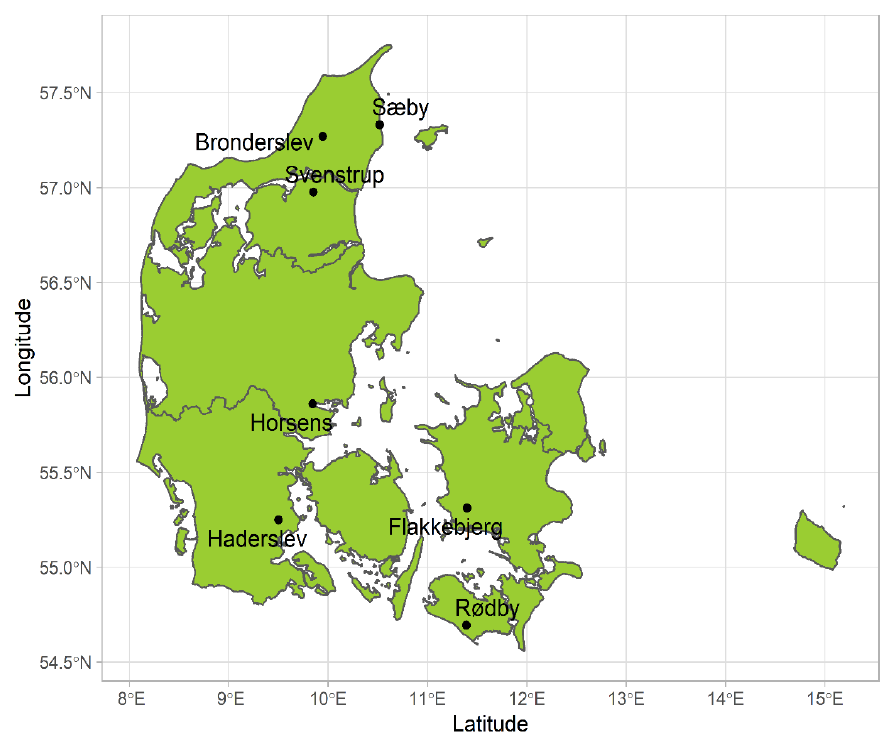
Figure 7. Locations of the field trials for data collection for model calibration and evaluation .